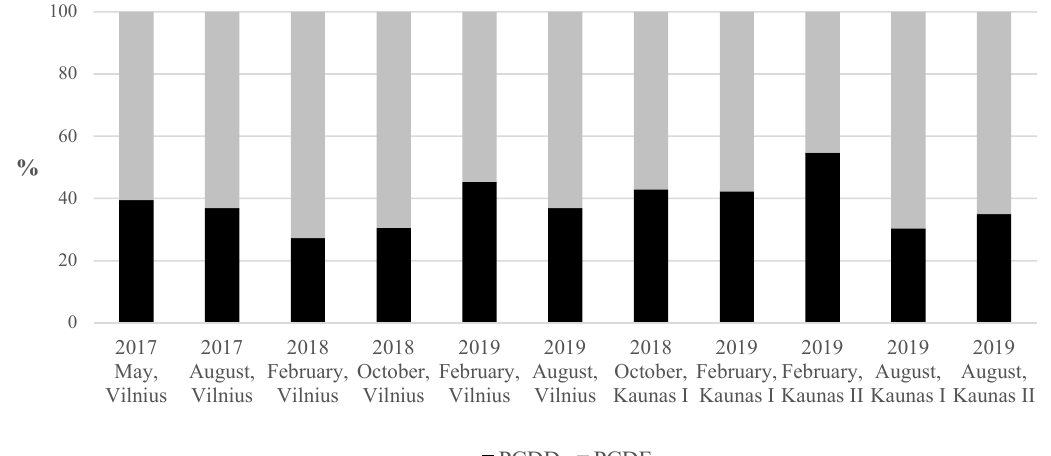
Figure 9. Polychlorinated dibenzofurans (PCDFs) TEQ in Vilnius and Kaunas (Vilnius-Lazdynai, Kaunas I-Ramuciai, Kaunas II-Partizanu str.).